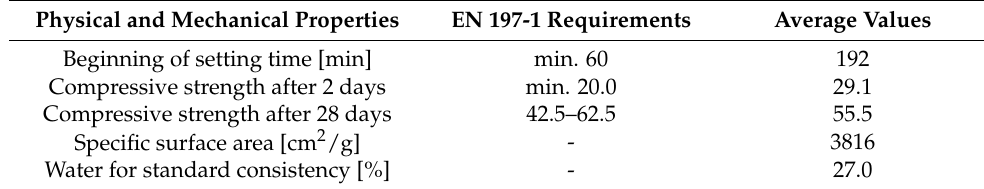
Table 3. Physical and mechanical properties of cement. Physical and Mechanical Properties EN 197-1